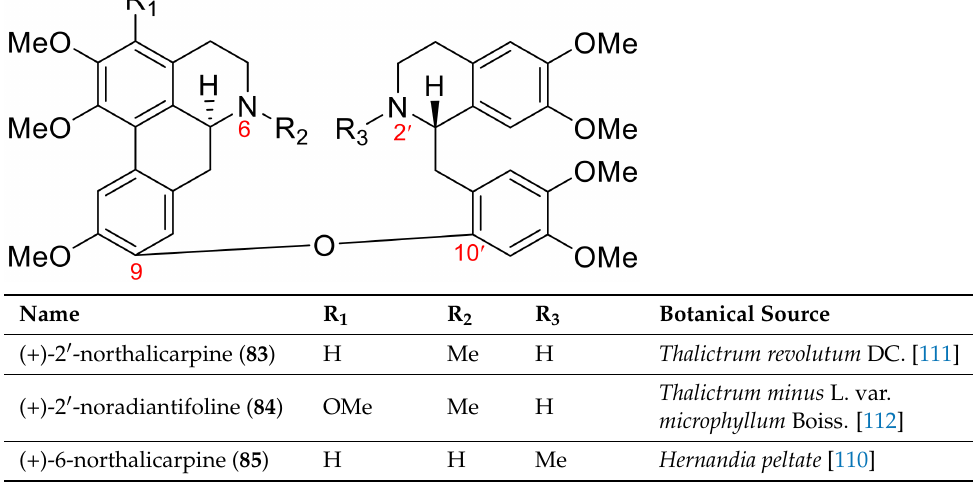
Table 8. 2 (cid:48) -or 6-Noraporphine–benzylisoquinoline dimeric alkaloids of the thalicarpine